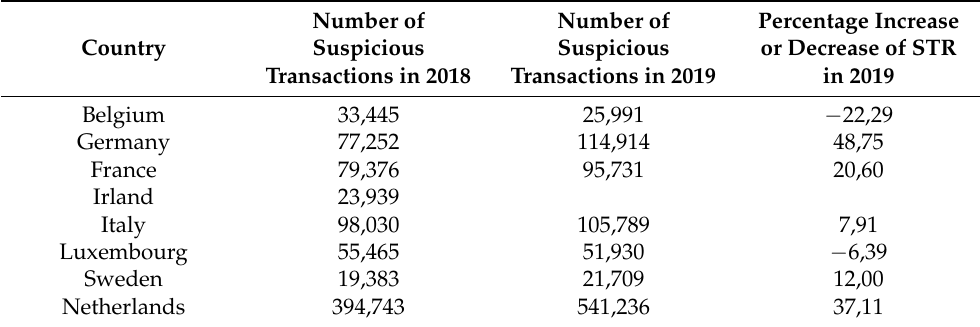
Table 1. Member states’ Financial Intelligence Units (FIUs) that received a number of suspicious transactions larger than 20,000 in 2018 or